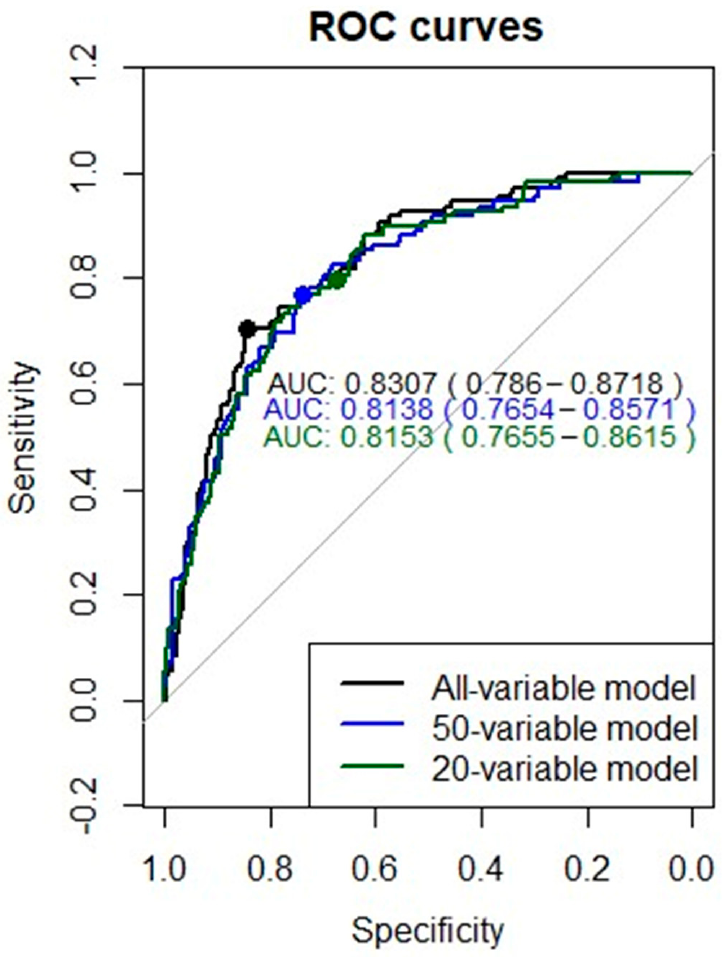
Figure 6. ROC curves of the analysed models considering all variables, 50 variables, and the 20 most influential variables.